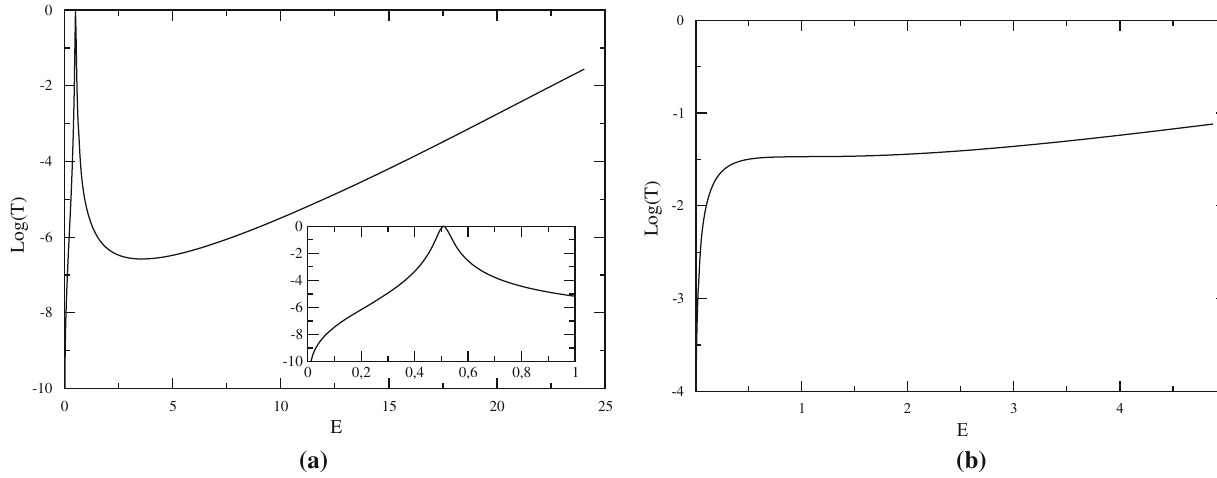
Fig. 8 Transmission coefficient in kink scenario for KR field as function of E = m 2